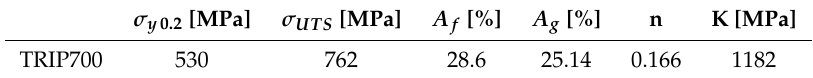
Figure 11. Geometry of tensile specimen (ASTM E8M). Table 3. Mechanical properties of TRIP